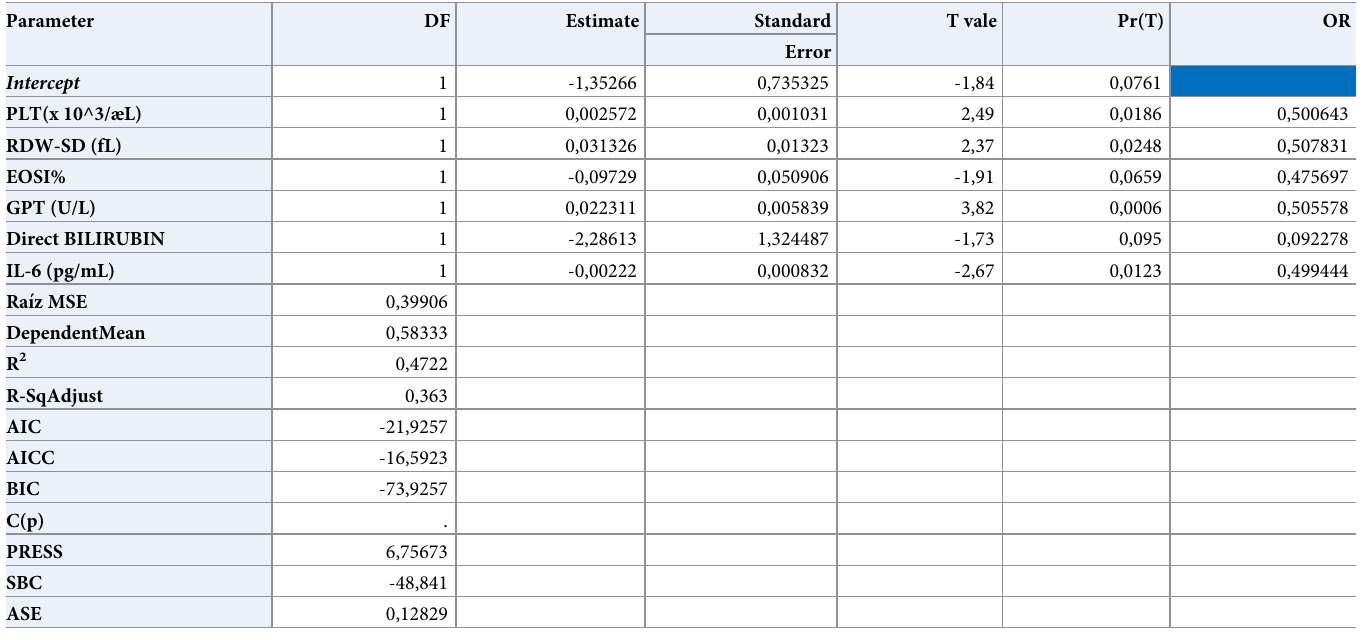
Table 4. Results of the General Linear Model (stepwise full model) used to test for each patient the association between haematochemical examinations performed at the baseline (dependent variables) and the subsequent radiological features at month 3 (independent variable). Parameter